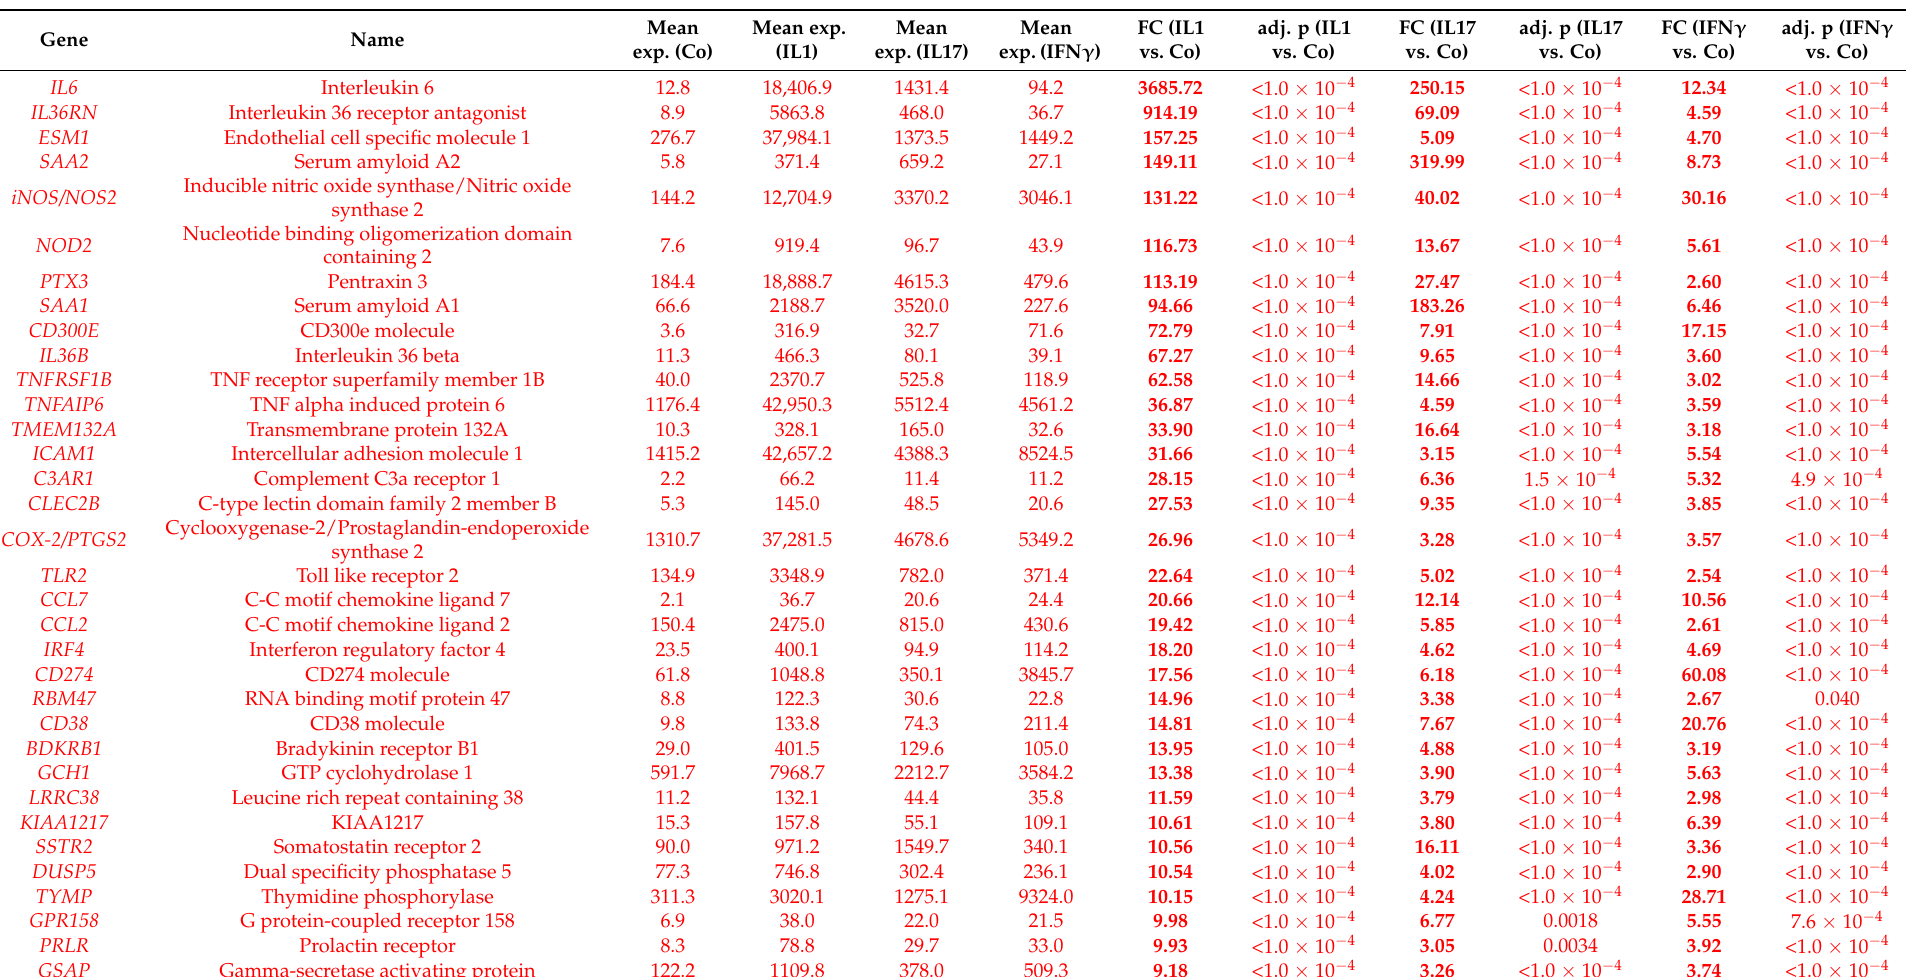
Table 5. Genes upregulated by all studied proinflammatory cytokines with FC > 2.5. Shown are mean normalized expression levels in control (Co) and in C(IL1), C(IL17) and C(IFN γ ) phenotypes, fold changes (FCs) for all comparisons vs. control and false discovery rate (FDR)-adjusted p values for